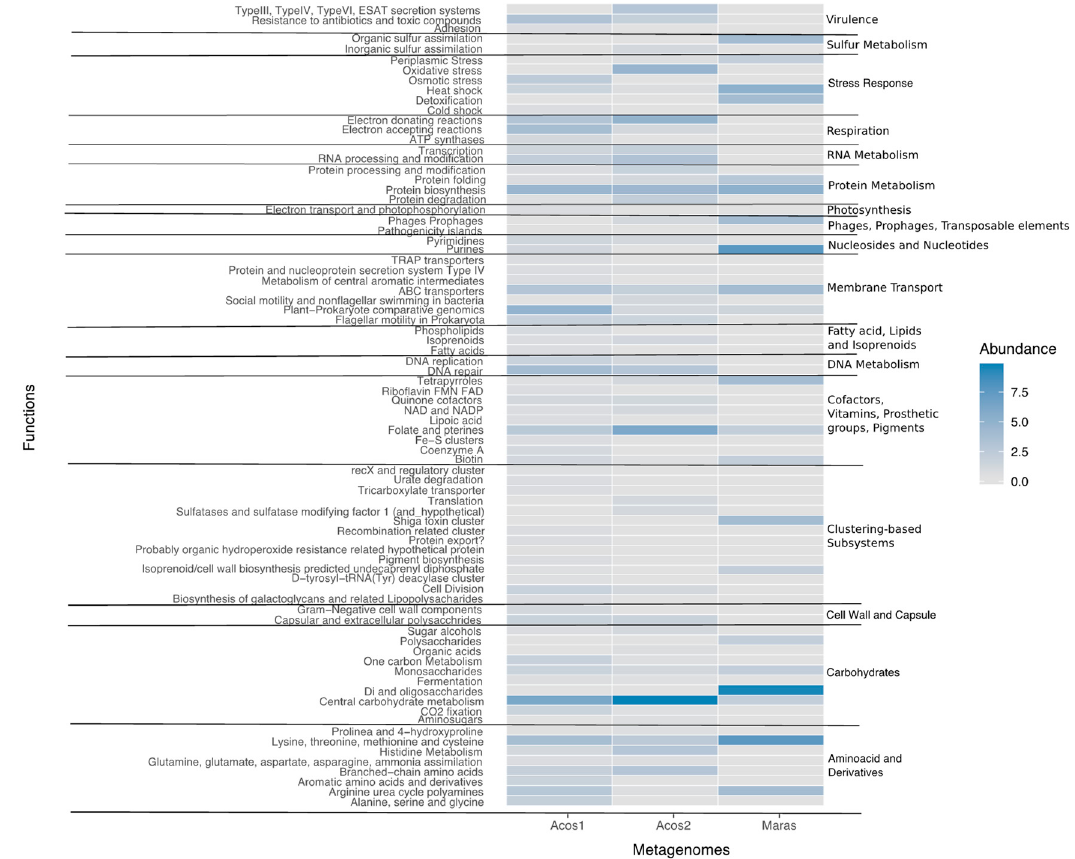
Figure 10. Heatmap of the relative abundance of proteins based on SEED classifications.